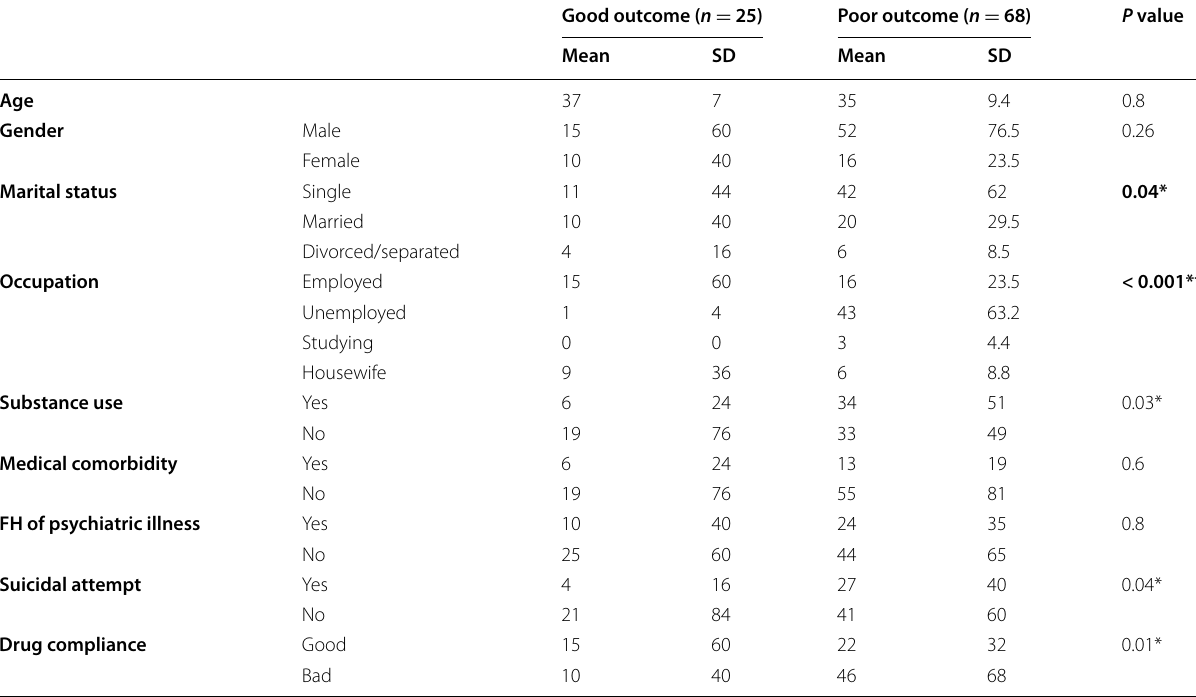
Table 4 Relation between socio-demographic characteristics and clinical findings of outcome groups